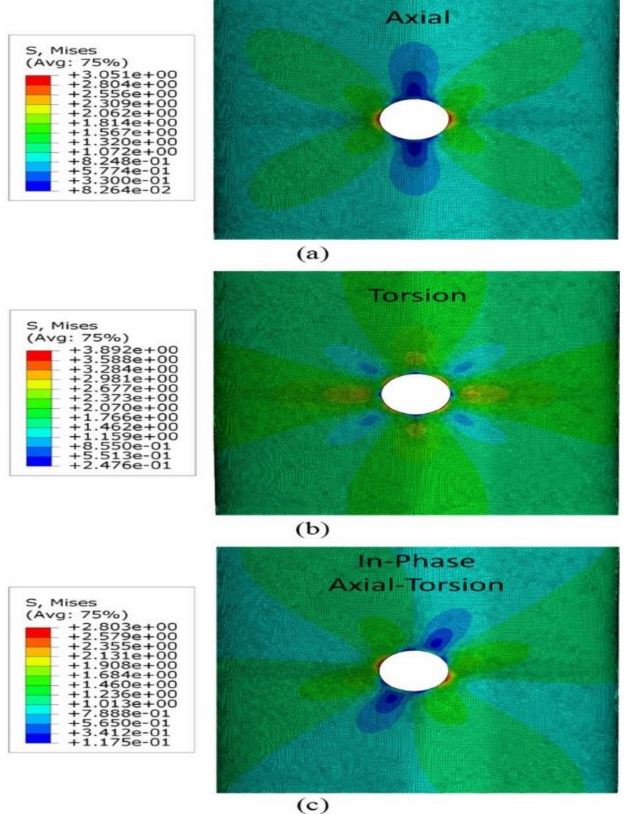
Figure 26. Von Mises equivalent stress distributions around the transverse hole of thin-walled tubular specimens under axial ( a ), torsion ( b ), and combined axial-torsion loads ( c ). Nominal applied VM stresses were equivalent to 1 MPa on the outer surface of the specimens. Part ( c ) had a nominal surface stress ratio of σ / τ = 3. Reprinted with permission from ref. [75]. 2020,